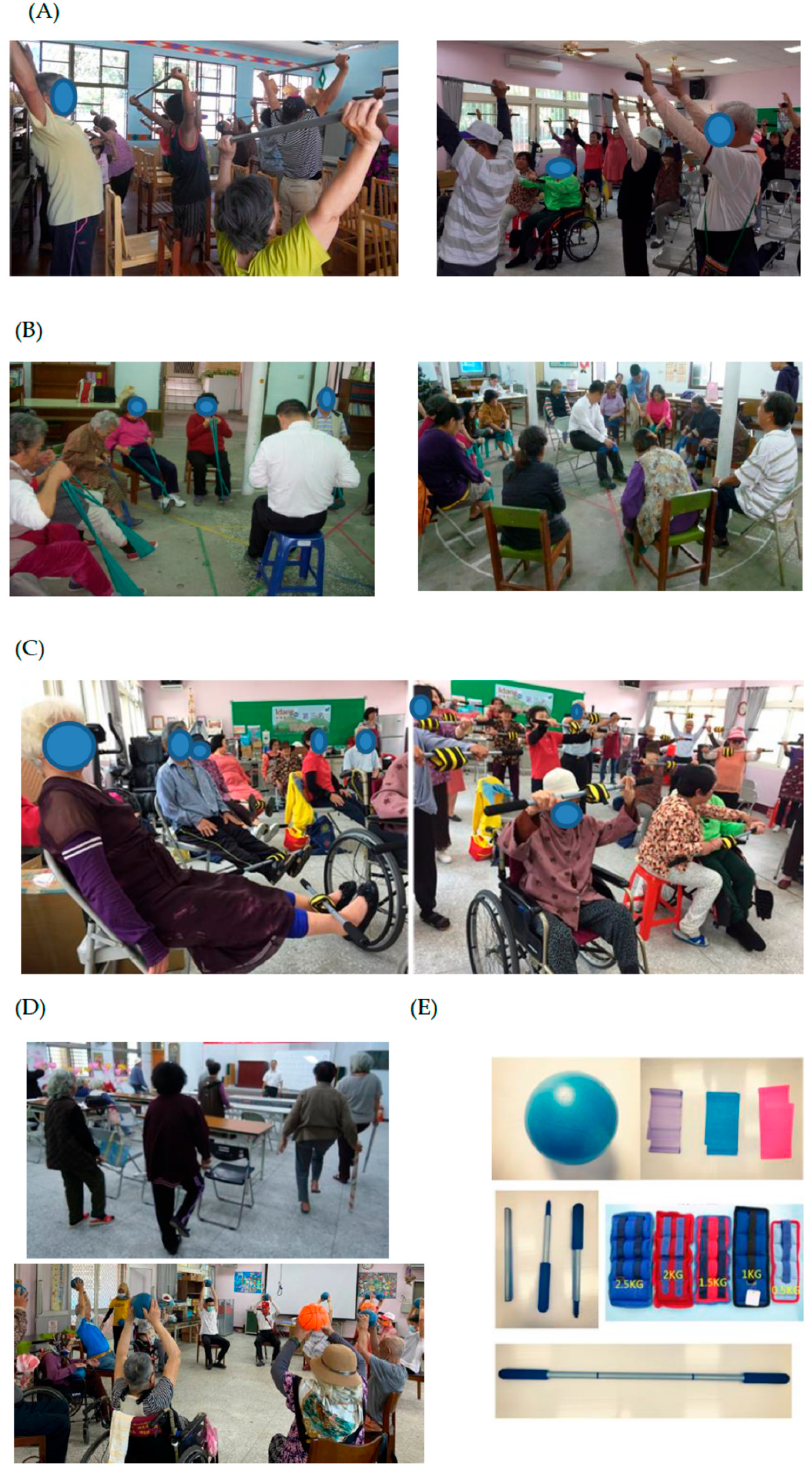
Figure 1. The exercise program by using exercise toolkit in three phases for the community older adults participating in the CCS program. ( A ) Stretching and flexibility exercises with a stick or trekking pole. ( B ) Resistance training for upper and lower limbs by using a theraband. ( C ) Using a stick combing with a sandbag for muscle strengthening for upper and lower limbs. ( D ) Balance training with or without support by chair or stick and coordination by using a small ball. ( E ) The exercise toolkit containing a stick (length 100–110 cm) or trekking pole, therabands, sandbags and a small